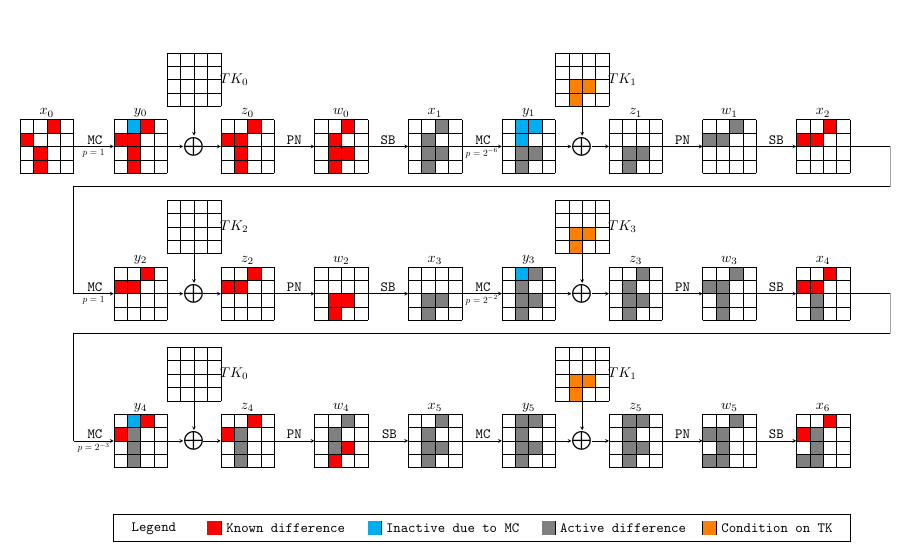
Figure 10: A 6-round truncated differential trail of CRAFT with probability 2 − 11